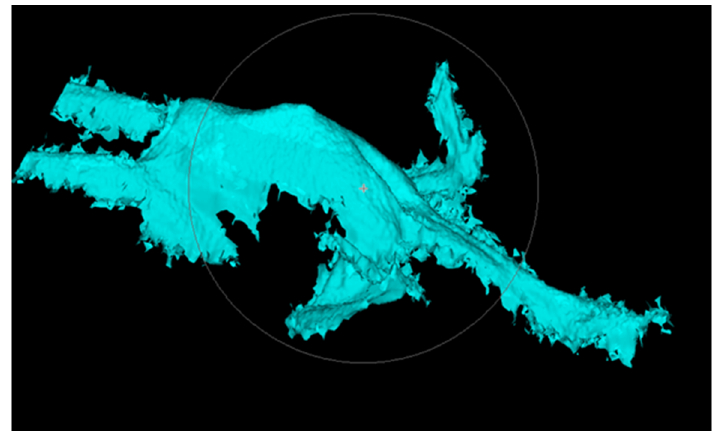
Figure 1. Example of a blue pattern on the carcass.